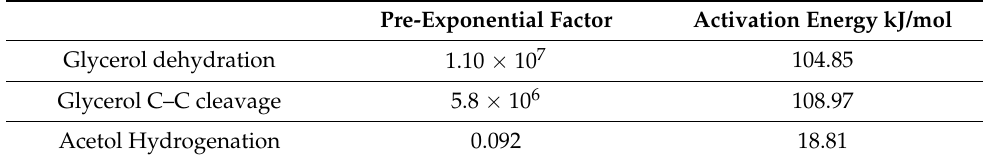
Table A7. Estimated kinetic parameters.